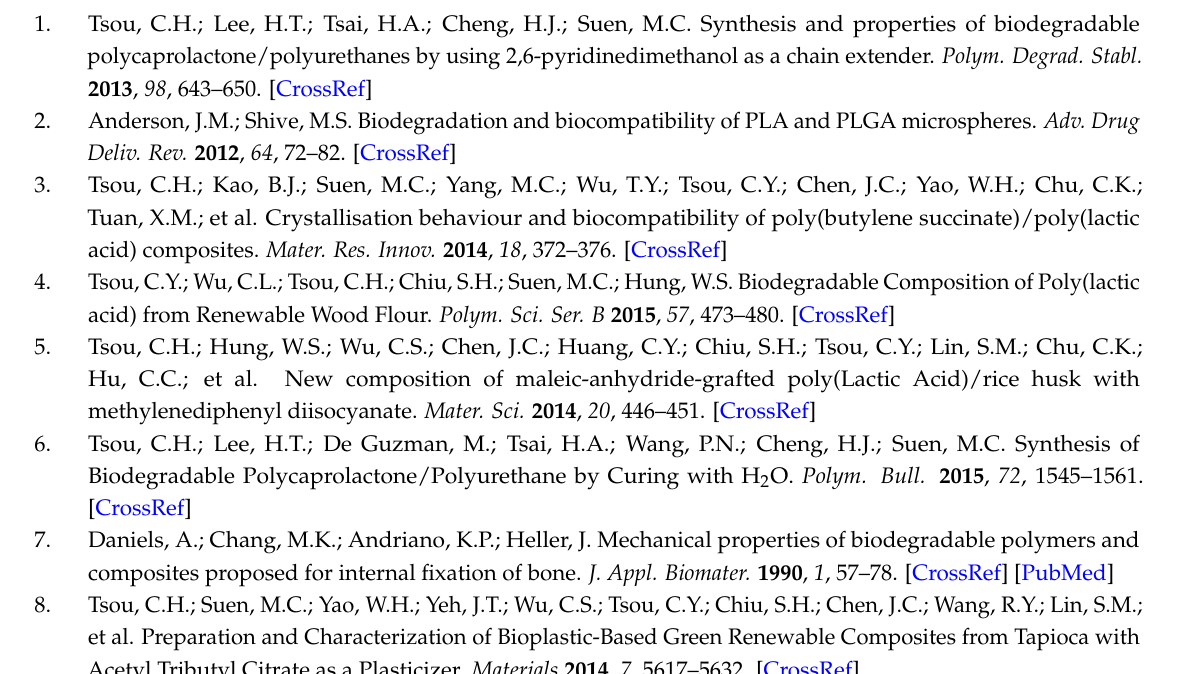
Figure S1: The appearance of (a) MWCNT and (b) MWCNT-Ag, Figure Figure S2: The color of PLA nd PLA/MWCNT-Ag nanocomposites. Figure S3: DTG curves of PLA and PLA/MWCNT-Ag nanocomposites. Figure S4: DSC curves of PLA and PLA/MWCNT-Ag nanocomposites. Figure S5: L929 fibroblasts cultured for control. Figure S6: L929 fibroblasts cultured for 2 d with (a) positive control; (b) negative control; (c) PLA; (d) PLA/MWCNT-Ag 0.1 ; (e) PLA/MWCNT-Ag 0.2 ; and (f) PLA/MWCNT-Ag 0.3